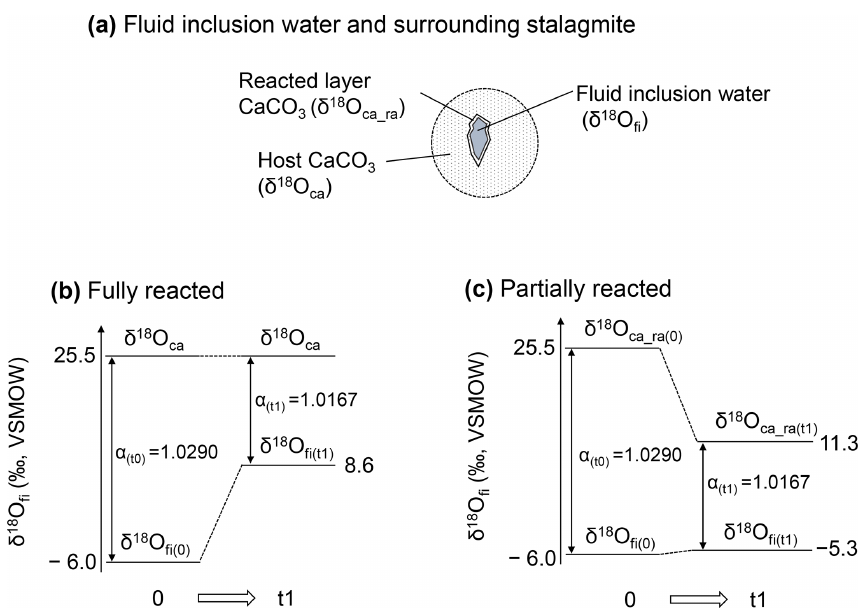
Figure 5. Schematic illustration of isotopic re-equilibration between inclusion water and stalagmite. (a) Schematic illustration of a water- filled fluid inclusion and surrounding CaCO 3 . (b) Changes in the isotopic composition for the fully reacted hypothesis, in which the δ 18 O fi value changes in response to equilibration with an infinite amount of host CaCO 3 . In this case, the sample at room temperature (25 ◦ C at time of 0) is heated to 105 ◦ C and reaches a new isotopic equilibrium at time t 1 . (c) The same as (b) but for the partially reacted hypothesis, in which the δ 18 O fi value changes in response to equilibration with a limited amount of CaCO 3 . Note that the calcite–water fractionation factor is the same for both